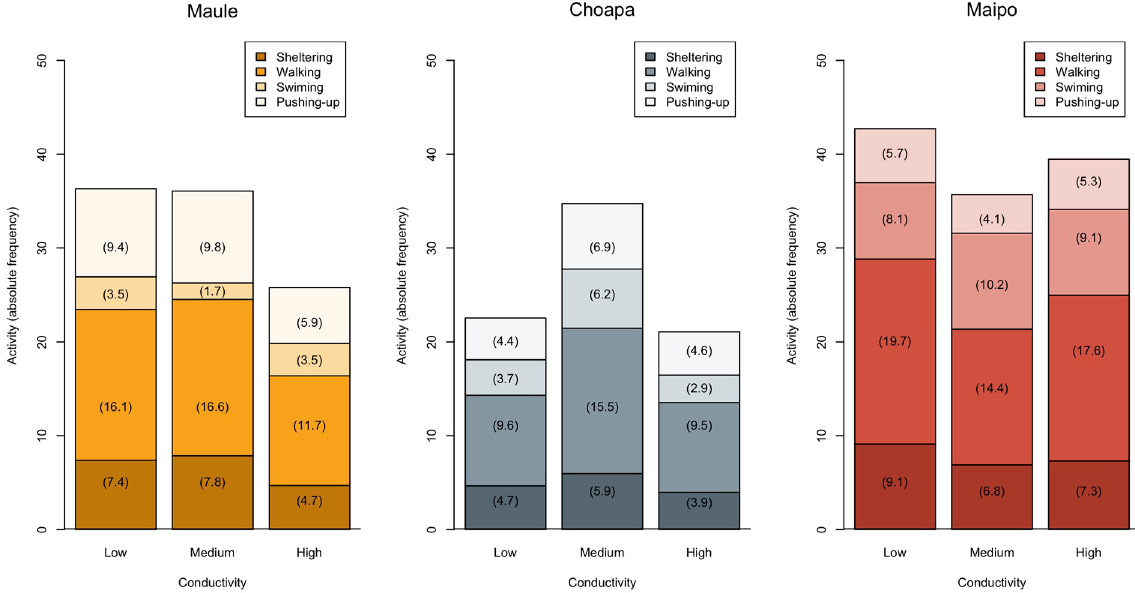
Fig 3. Behavioral responses. Mean total activity and its decomposition into specific behavioral responses exhibited by S. annulicornis . Values of activity levels are shown in parenthesis. Organisms came from three river basins: Choapa, Maipo and Maule. Experimental conductivity levels were: low (180 μ S/cm), medium (500 μ S/cm) and high (1400 μ S/cm).